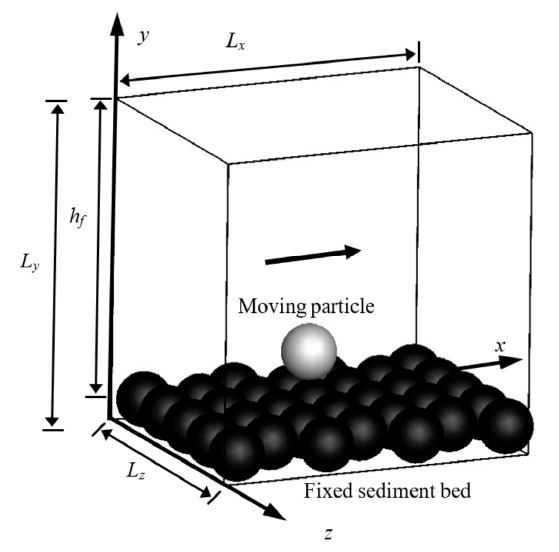
Figure 1. Computational domain and coordinate system.